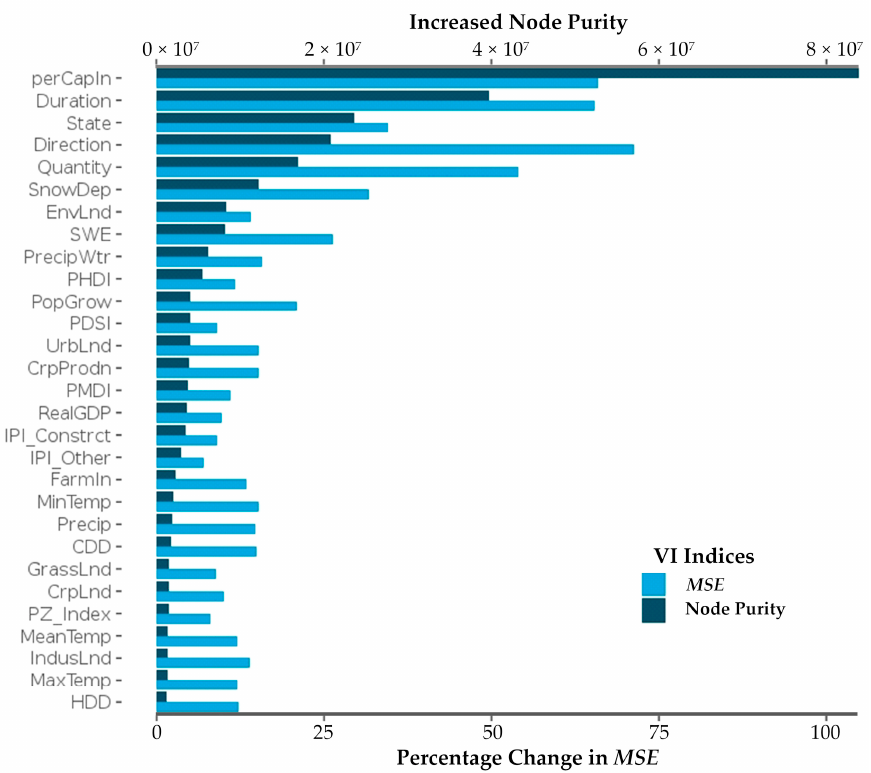
Figure 8. Variable importance rankings for all predictor variables averaged through multiple runs. The dark blue bars represent the decreased node impurities as each variable is used for partitioning; the light blue bars represent the percentage change in mean squared errors of model prediction before and after permuting each variable. The variable names on the vertical axis are ranked by their decreased node impurities in descending order.